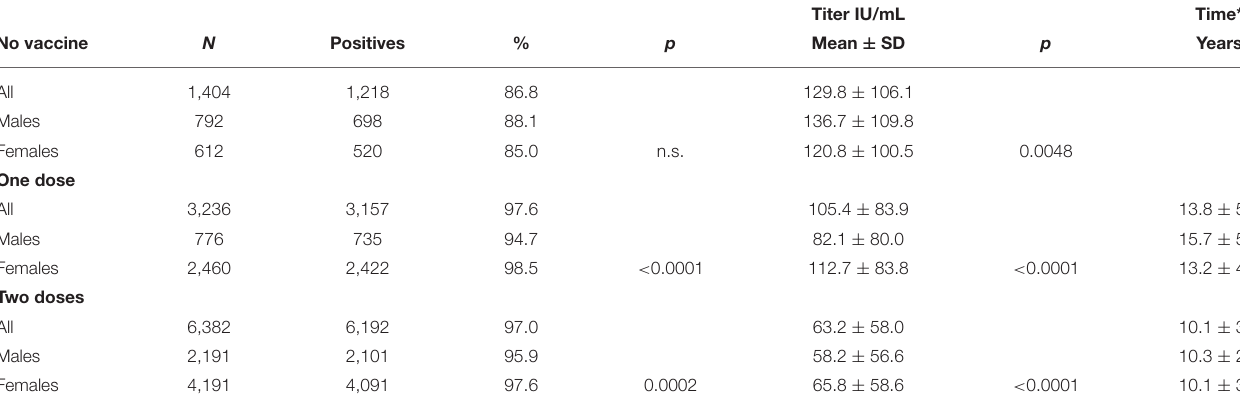
TABLE 1 | Seropositivity and antibody titer in unvaccinated students and students vaccinated with one or two doses.